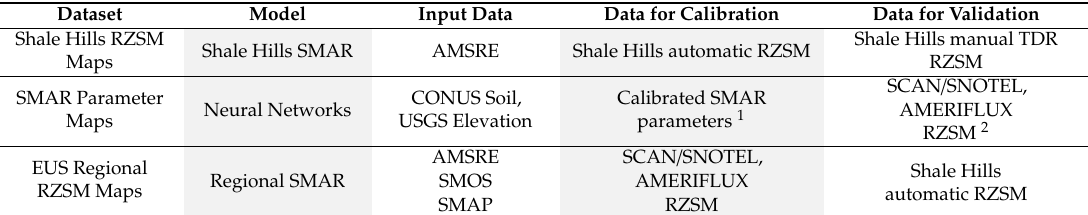
Table 2. The three types of outputs generated by SMAR modeling conducted for this